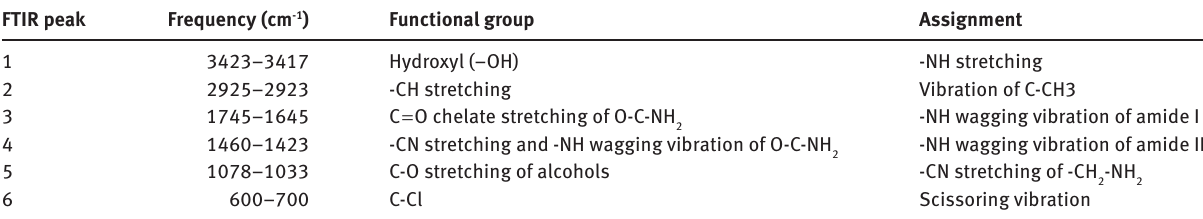
Table 5: Functional groups of the A. flavus (F3) biomass and corresponding FTIR adsorption frequencies.